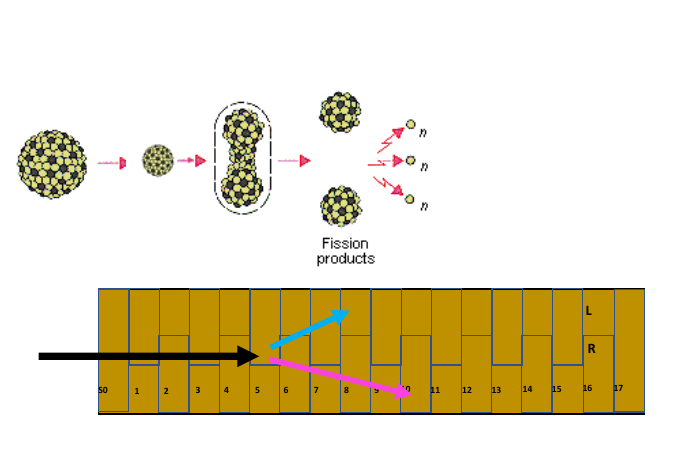
Figure 1. Schematics of a fusion-induced fission event and the segmented anode in MUSIC representing a fission event occuring in strip 5.